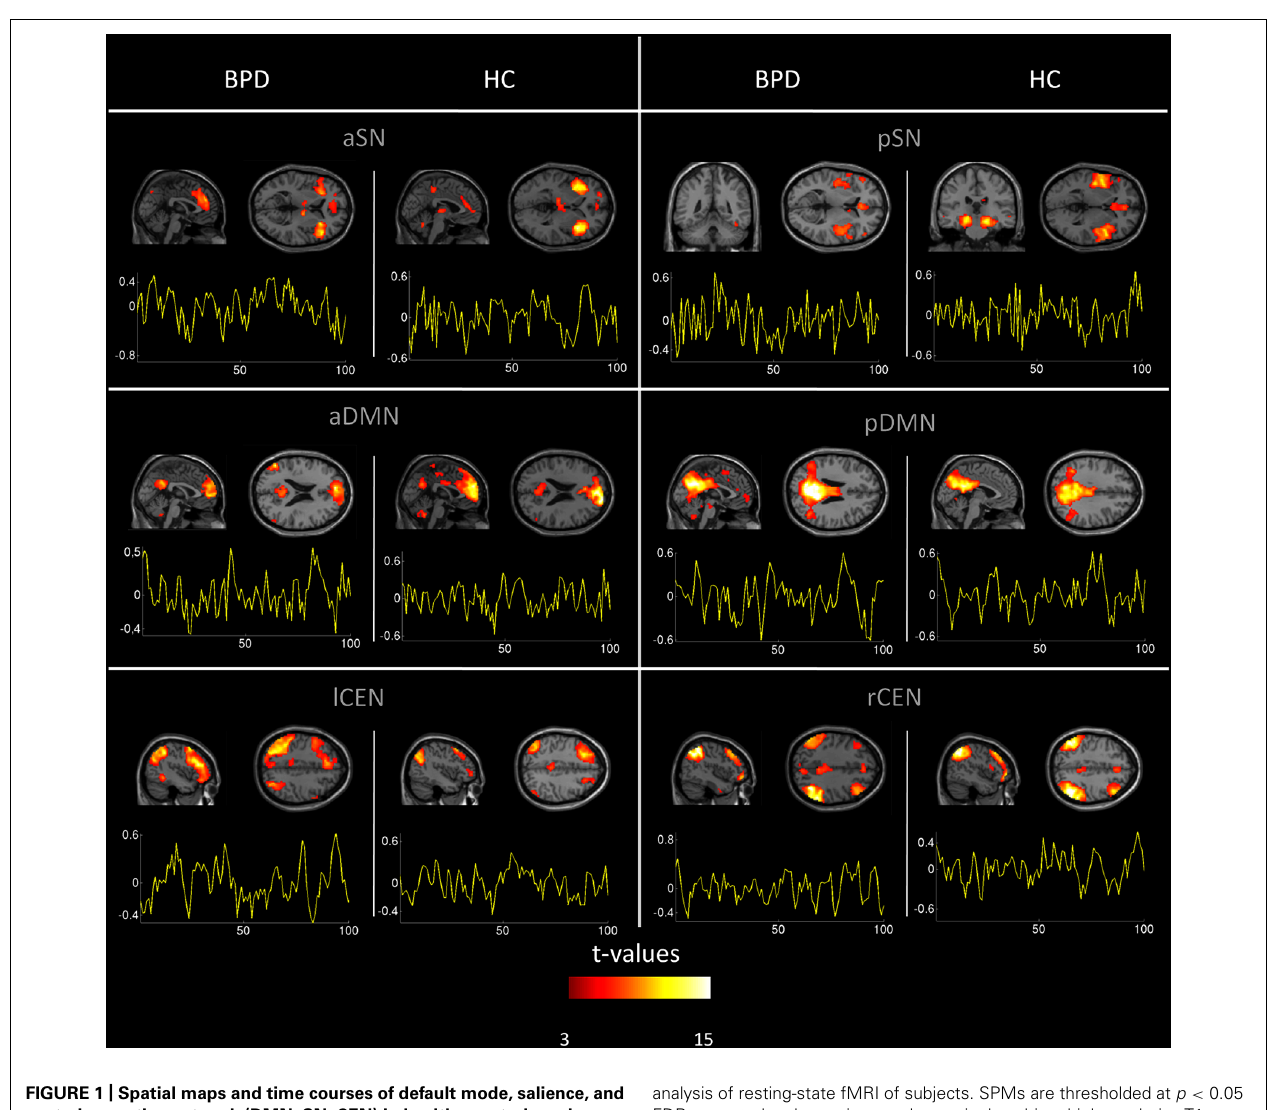
FIGURE 1 | Spatial maps and time courses of default mode, salience, and central executive network (DMN, SN, CEN) in healthy controls and patients. Spatial statistical parametric maps (SPM, one-sample t -tests controlled for medication) and associated time courses of intrinsic networks in healthy controls (HC) and patients with borderline personality disorder (BPD). Maps and time courses are derived from independent component